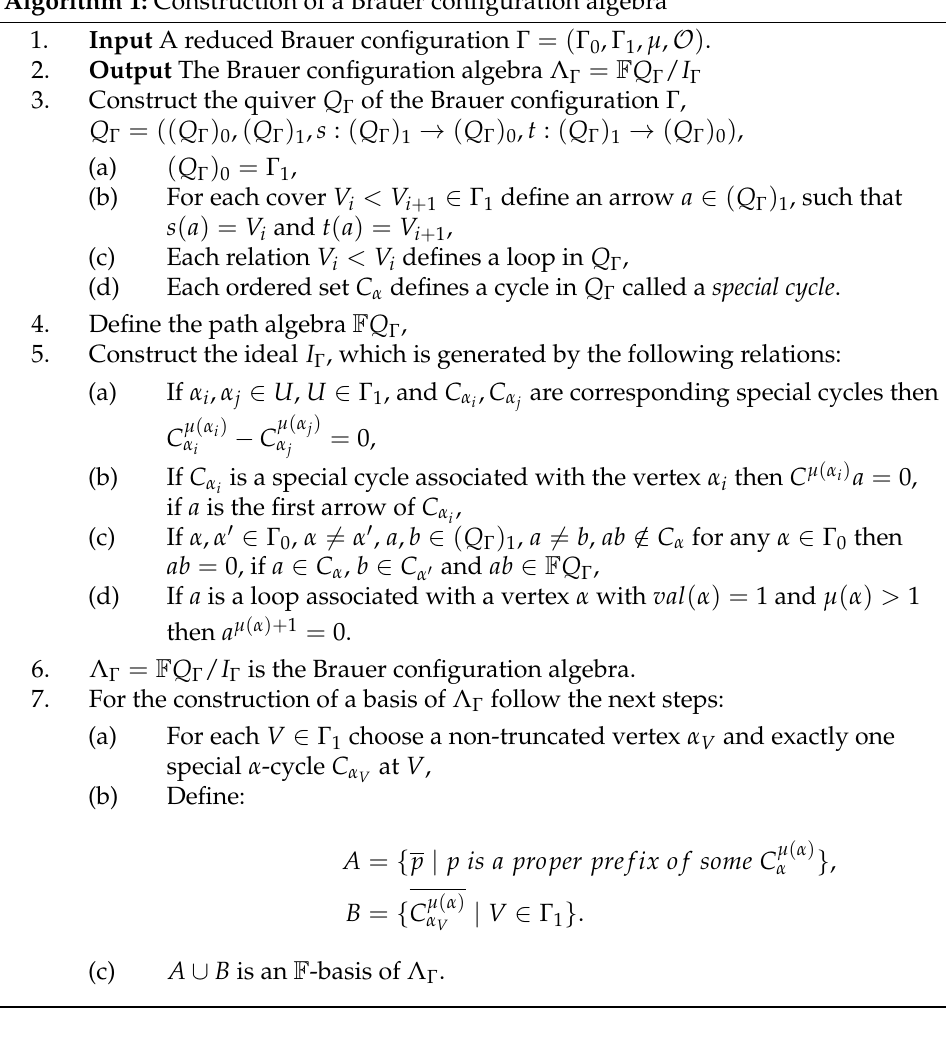
Algorithm 1: Construction of a Brauer configuration